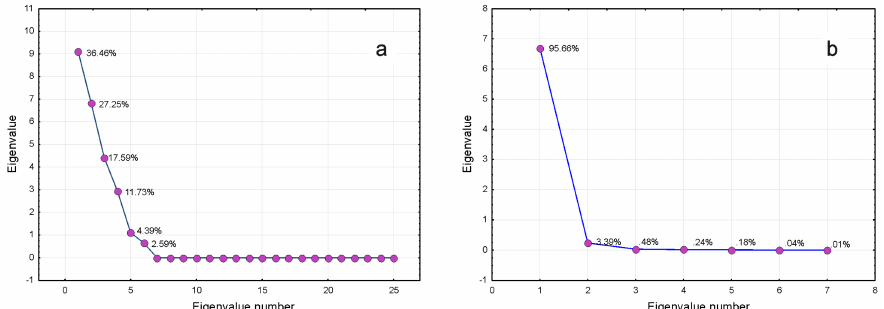
Figure 3. The screen plots corresponding to R-mode ( a ) and Q-mode ( b )